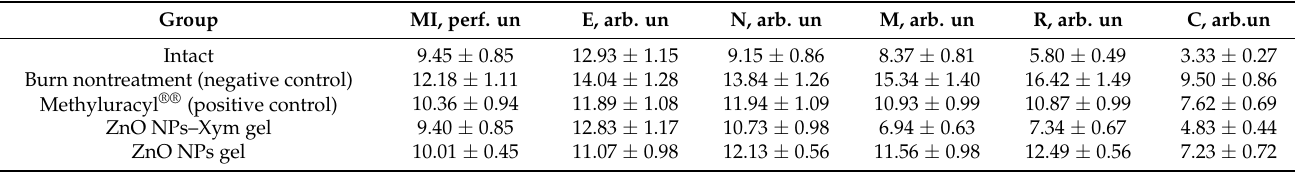
Table 6. The microhemicirculatory indexes calculated by laser Doppler flowmetry for intact rats, untreated burnt rats (day 0), and burnt rats (day 10) under the treatment by ZnO NPs–Xym gel, ZnO NPs gel, and Methyluracyl ®® ointment n = 3, p < 0.05. Group MI, perf. un E, arb. un N, arb. un M, arb. un R, arb. un C,